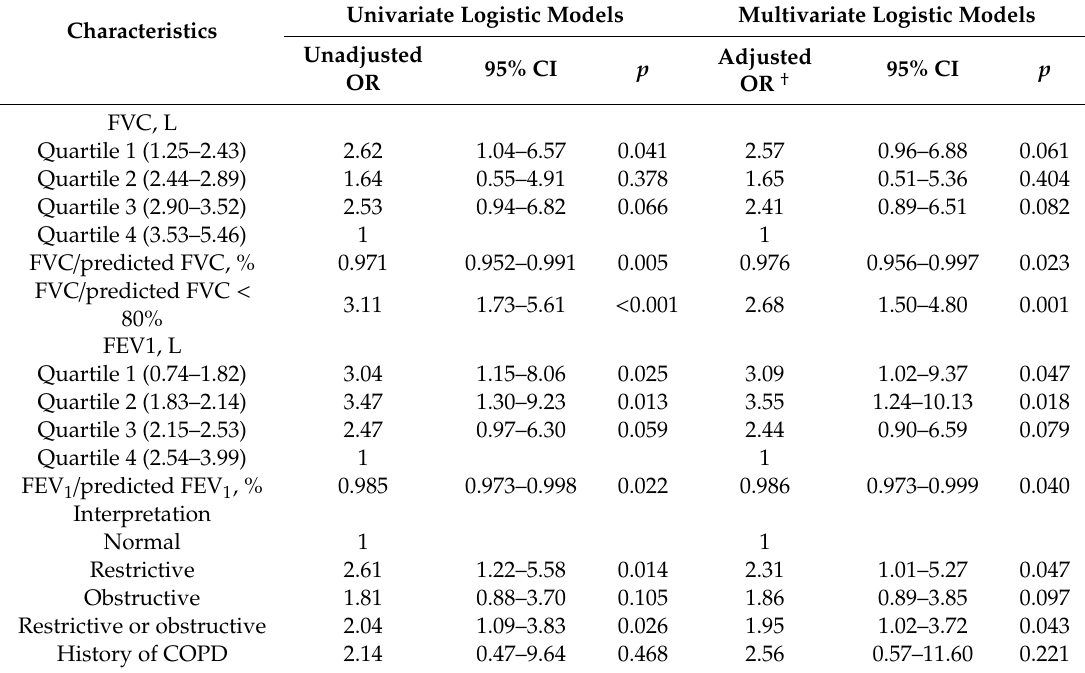
Univariate and multivariate logistic regression analysis of pulmonary function for irregular